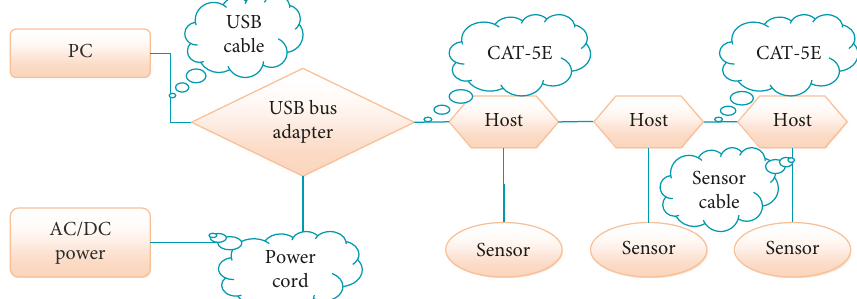
Figure 3: Schematic of the test system.